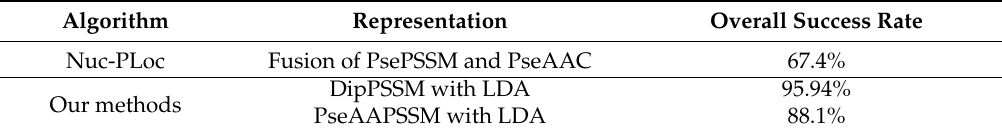
Table 8. Comparison of the overall success rates by jackknife test on Dataset 1.